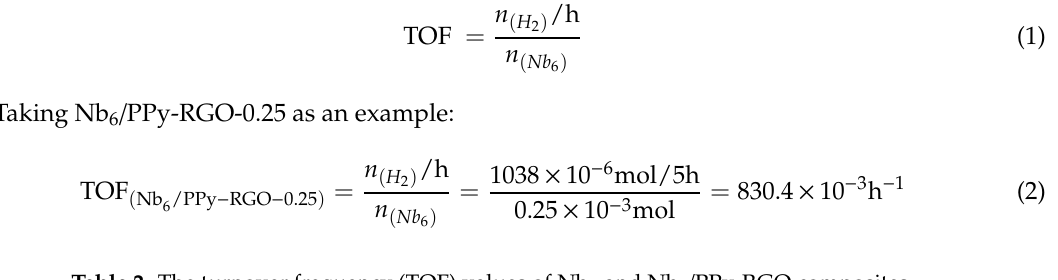
Table 2. The turnover frequency (TOF) values of Nb 6 and Nb 6 / PPy-RGO composites.